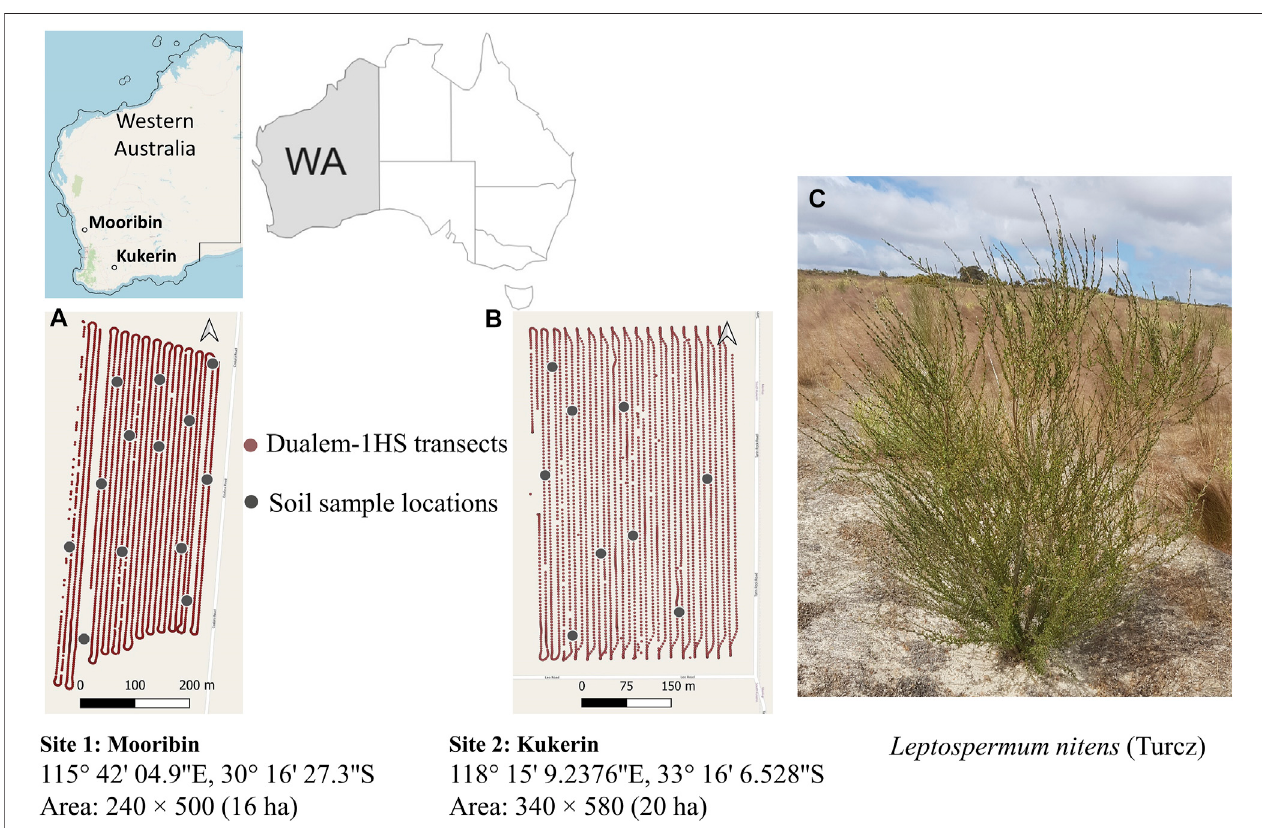
FIGURE 1 | Top, location of the study area in Western Australia. Bottom, (A) Site 1 – Mooribin and (B) site 2 – Kukerin. ECa transects with EMI reading points (red dots) and soil sample locations (gray dots) (C) Leptospermum nitens plant.